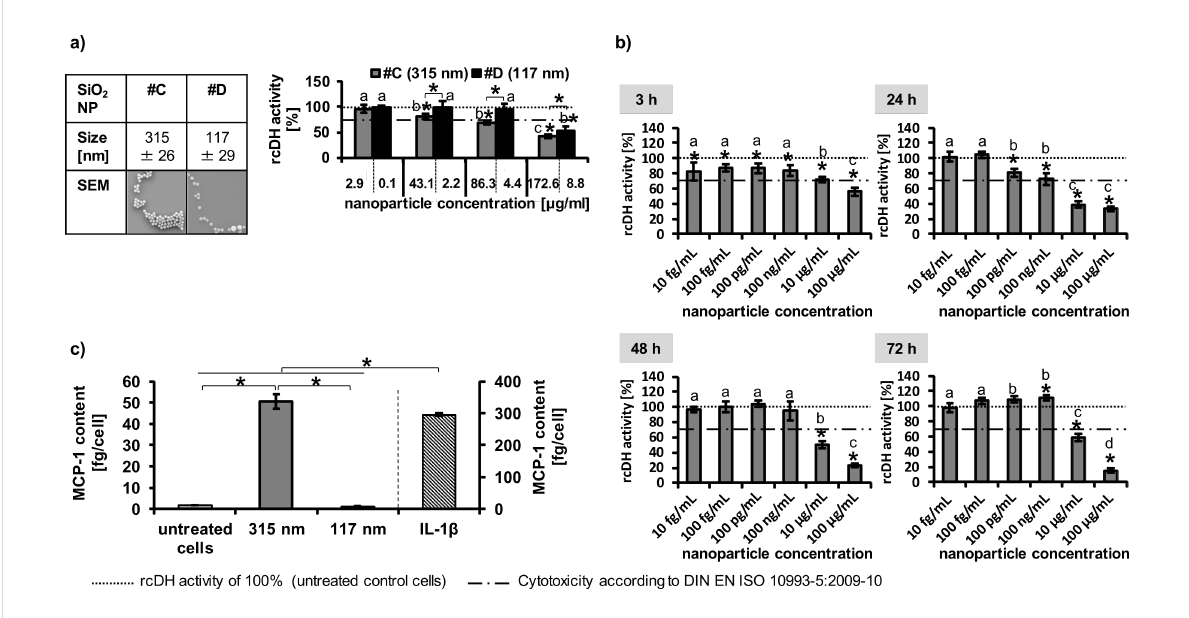
Figure 6: Metabolic impact of SiO 2 nanoparticles on endothelial cells. a) Impact of two different sized SiO 2 nanoparticles on HUVEC after 24 h ( n = 6). The different concentrations between the two different sized nanoparticles correspond to equal nanoparticle number per seeded cells (1,000 nanoparticles per seeded cell: nanoparticle sample #C: 2.9 µg/mL, sample #D: 0.1 µg/mL; 15,000 nanoparticles per seeded cell: sample #C: 43.1, sample #D: 2.2; 30,000 nanoparticles per seeded cell: sample #C: 86.3 µg/mL, sample #D: 4.4 µg/mL; 60,000 nanoparticles per seeded cell: sample #C: 172.6 µg/mL, sample #D: 8.8 µg/mL). b) Impact of 315 nm SiO 2 nanoparticles (sample #C) on HMEC-1 ( n = 6). c) The pro-inflammatory impact of SiO 2 nanoparticles (30,000 nanoparticles per cell [sample #C: 86.3 µg/mL; sample #D: 4.4 µg/mL]; 24 h incubation; HUVEC; n = 3)